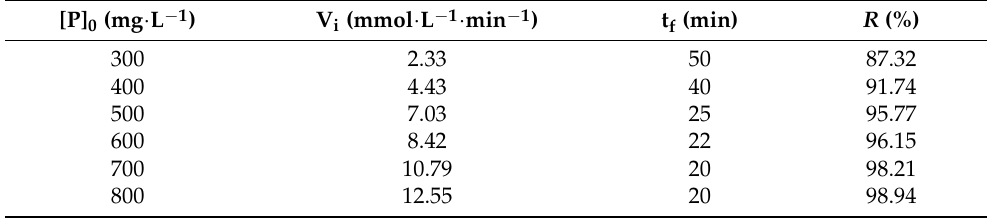
Table 3. End of precipitation time (t f ), the initial precipitation rate (V i ), and the phosphorus removal efficiency ( R %) obtained for different initial phosphorus concentrations ([P] 0 ), a stirring rate of 100 rpm and a solution volume of 600 mL.